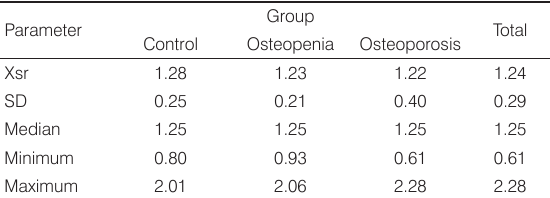
Table 2. HDL level in patients by group (mmol/L).